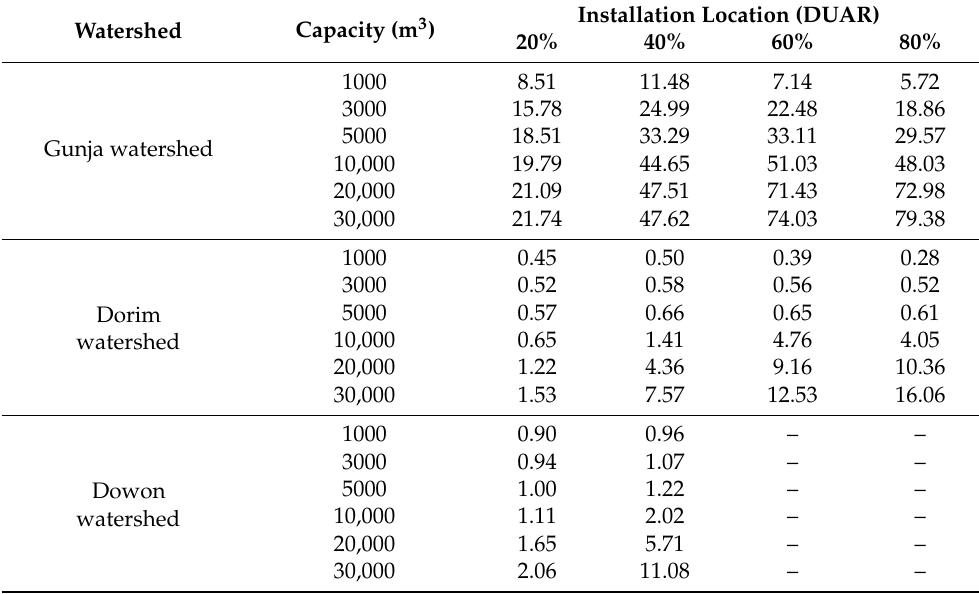
Table 4. Peak flow reduction by capacity and installation location of the trunk drainage